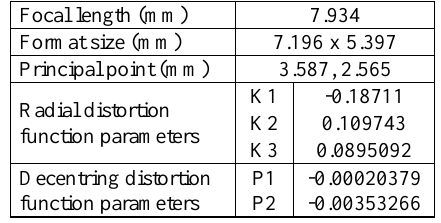
Table 1. Pentax Optio A40 calibration report